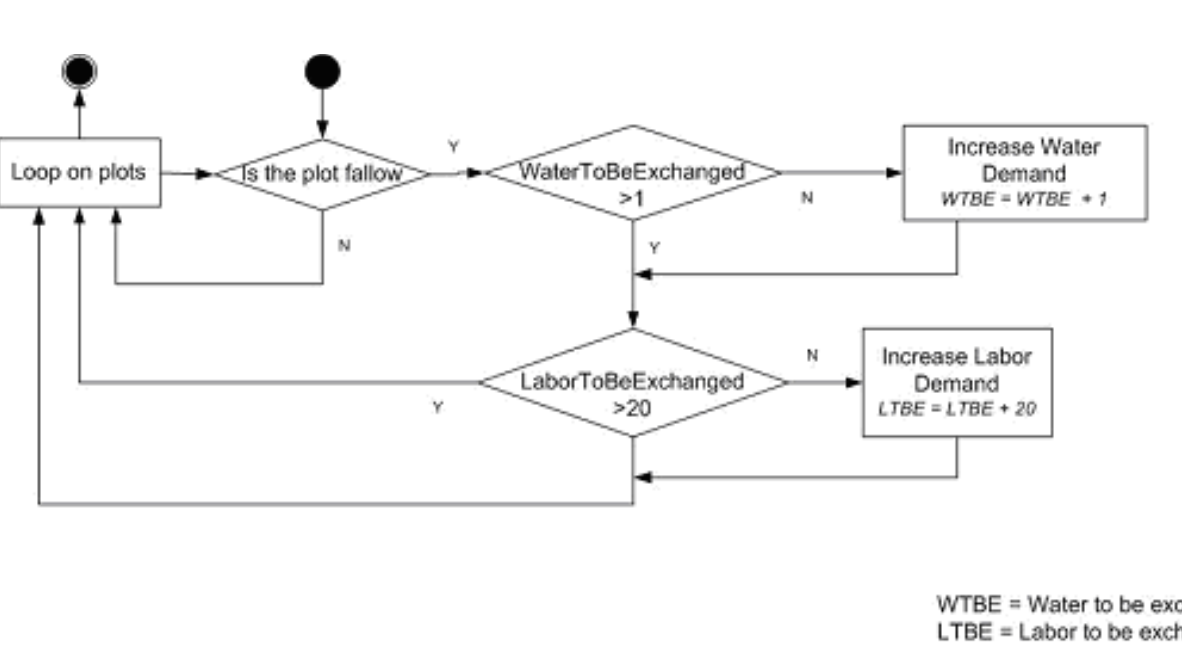
Fig. A2.3. The “PlantPotato” task in the Limbukha